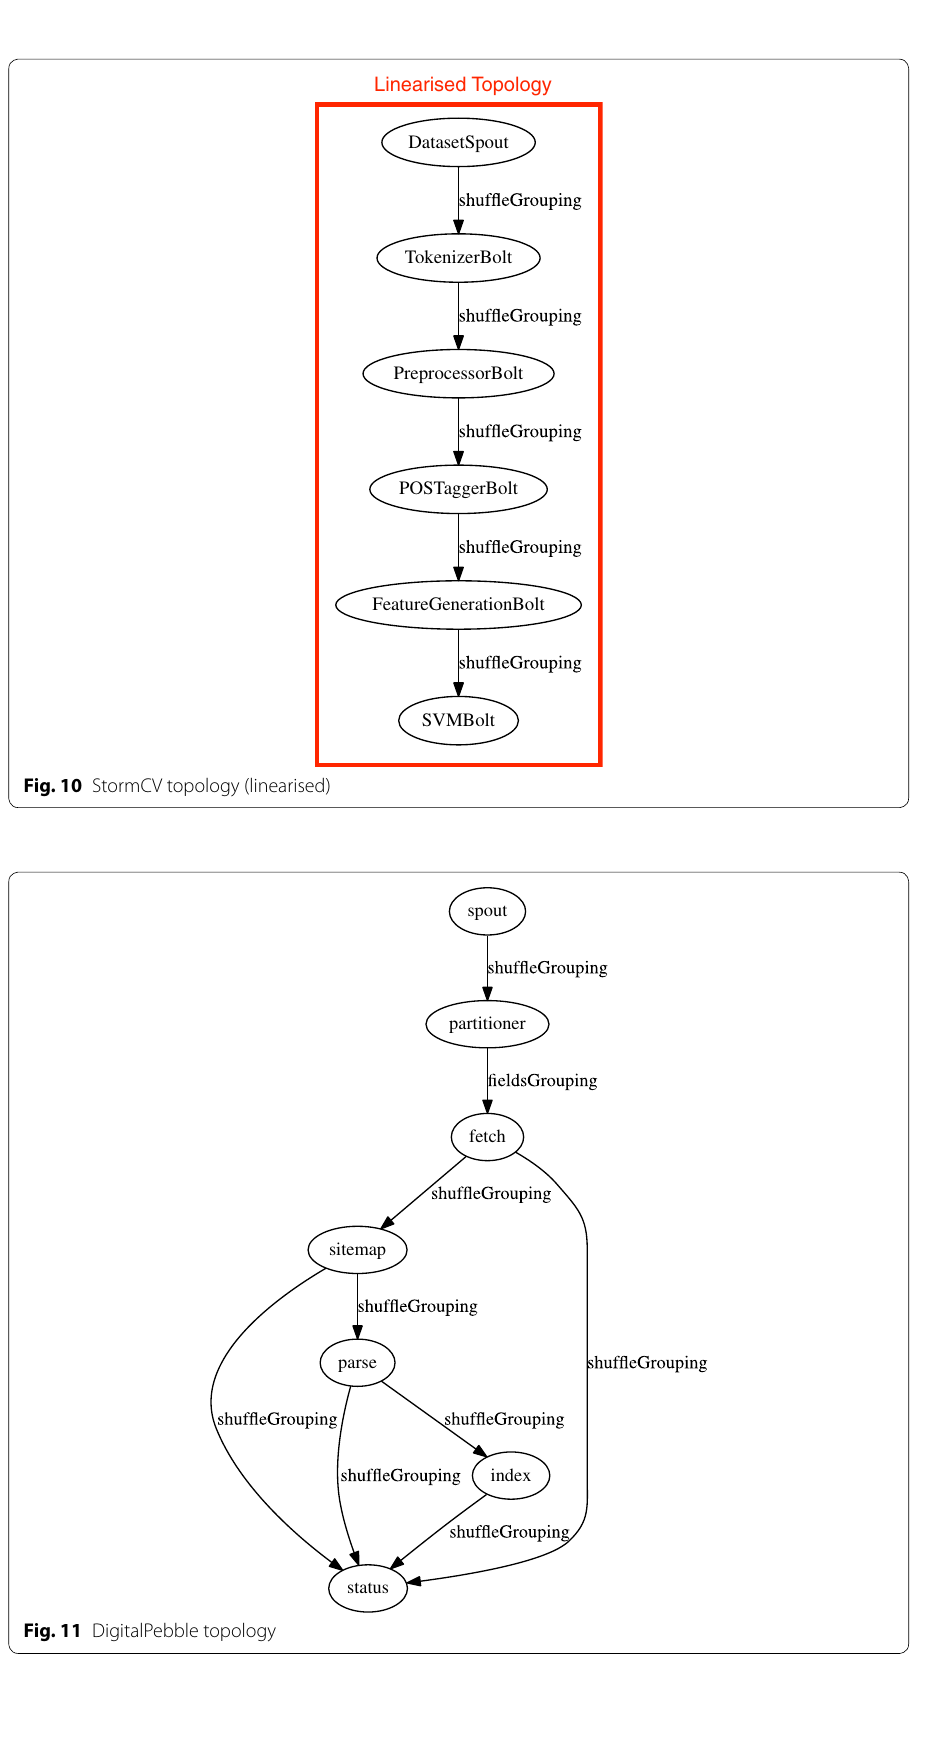
Fig. 11 DigitalPebble